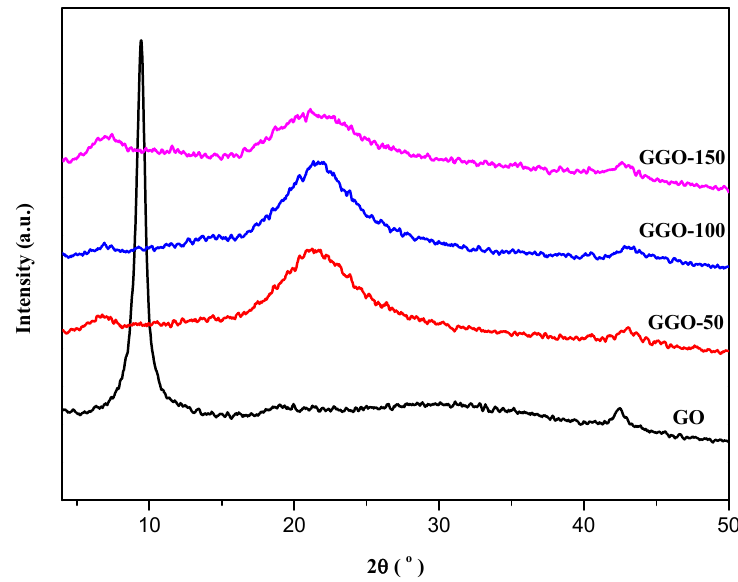
Figure 5. XRD spectra of GO and 3-glycidyloxypropyltrimethoxysilane functionalized-GO (GGO-50, GGO-100, and GGO-150).